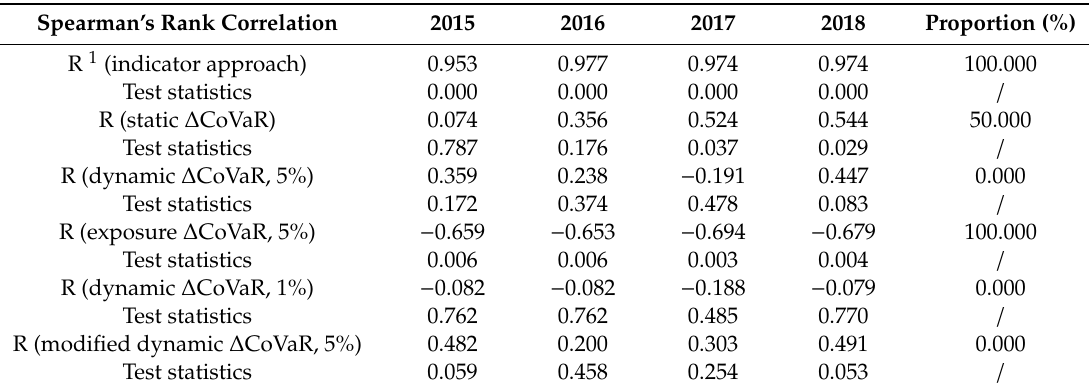
Table 7. The results of Spearman’s rank